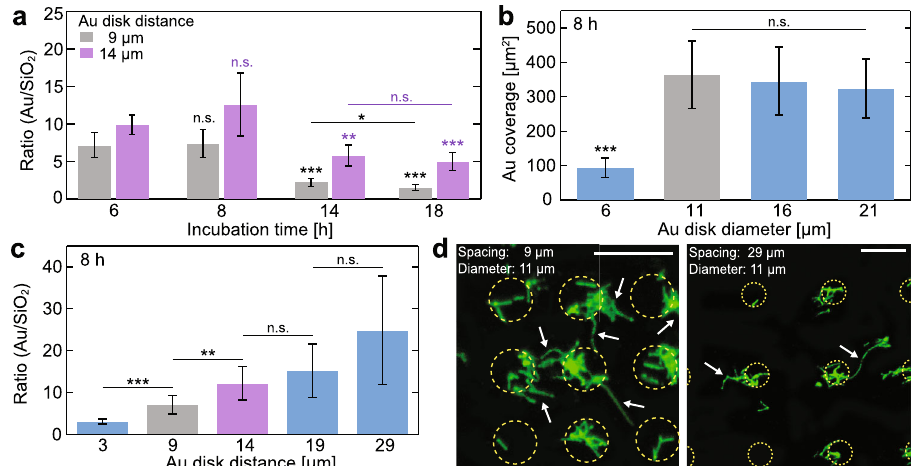
Fig. 2 Substrate-selectivity of bacterial adhesion in dependency of growth time, Au disk diameter, and Au pattern distance. a Bacterial adhesion ratio (mean ± s.d.) of Au to SiO 2 of circular Au disks arrays with 11 µm diameter, separated by 9 and 14 µm spacing for different growth times (6, 8, 14, 18 h). b Bacterial coverage (mean ± s.d.) on different Au disk diameters (6, 11, 16, 21 µm) with 9 µm spacing for 8 h growth time. c Bacterial adhesion ratio (mean ± s.d.) of Au to SiO 2 of circular Au disks arrays with 11 µm diameter, separated by different spacing (3, 9, 14, 19, 29 µm) for 8 h growth time. d Representative fl uorescence images of X. fastidiosa cells adhering to circular Au disks arrays with 11 µm diameter, separated by 9 µm (left) and 29 µm (right) spacing for 8 h growth time; scale depicts 20 µm. Asterisks indicate statistical signi fi cance (* p < 0.05; ** p < 0.01; *** p < 0.001; n.s. = non-signi fi cant), resulting from two-tailed, unpaired t -tests. See also Supplementary Fig.